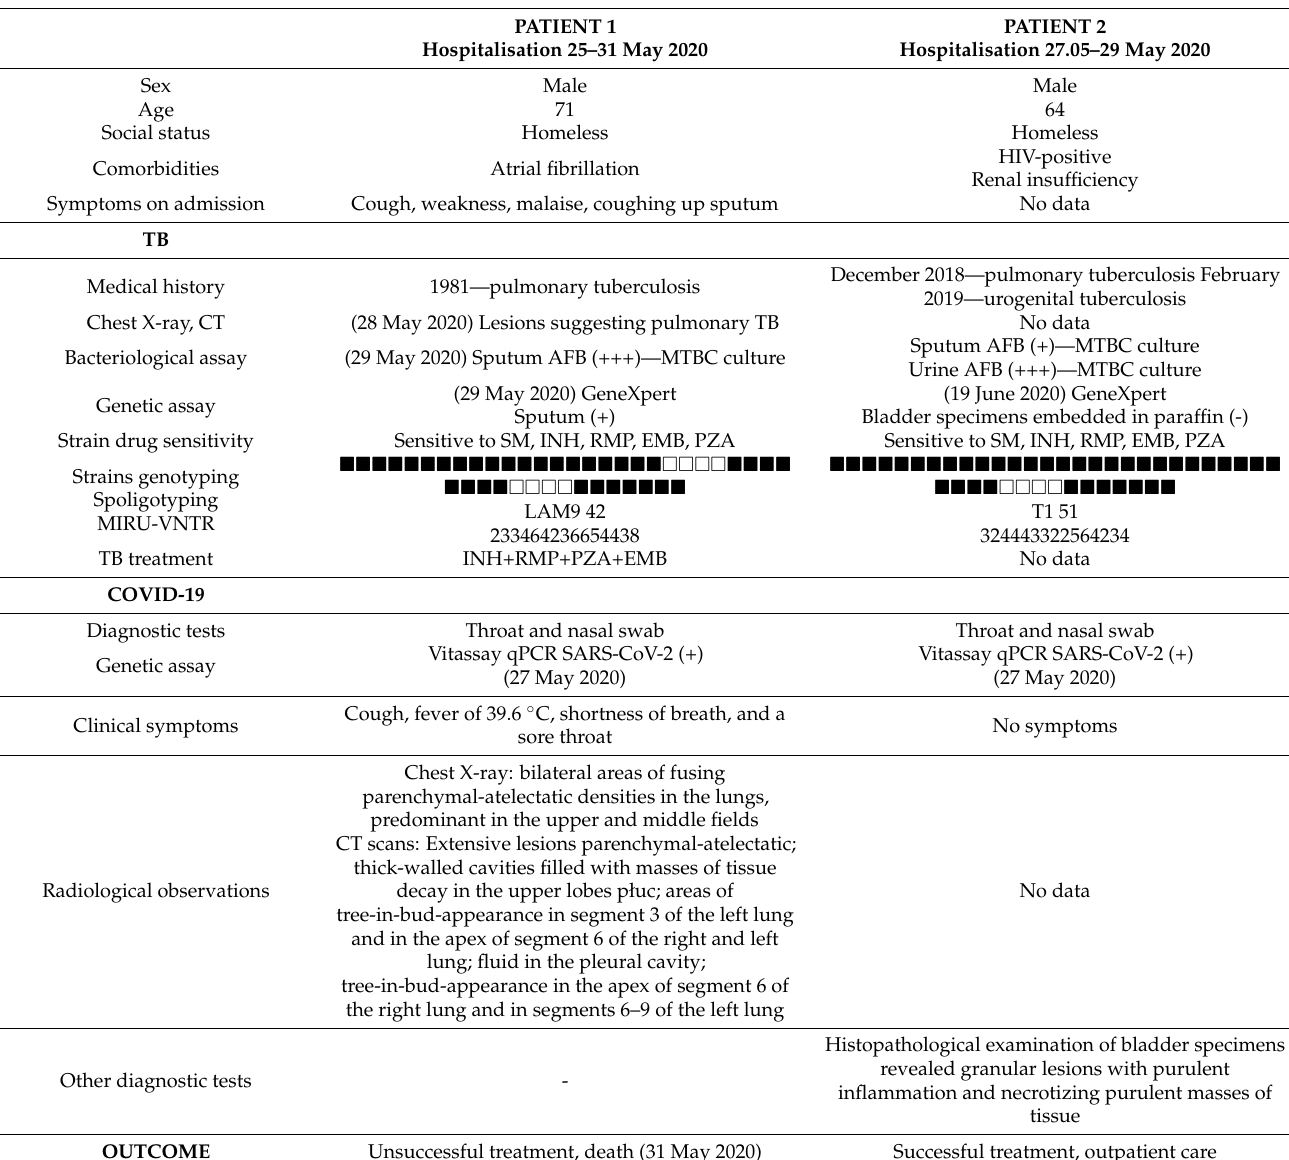
Table 1. Clinical and microbiological characteristics of reported